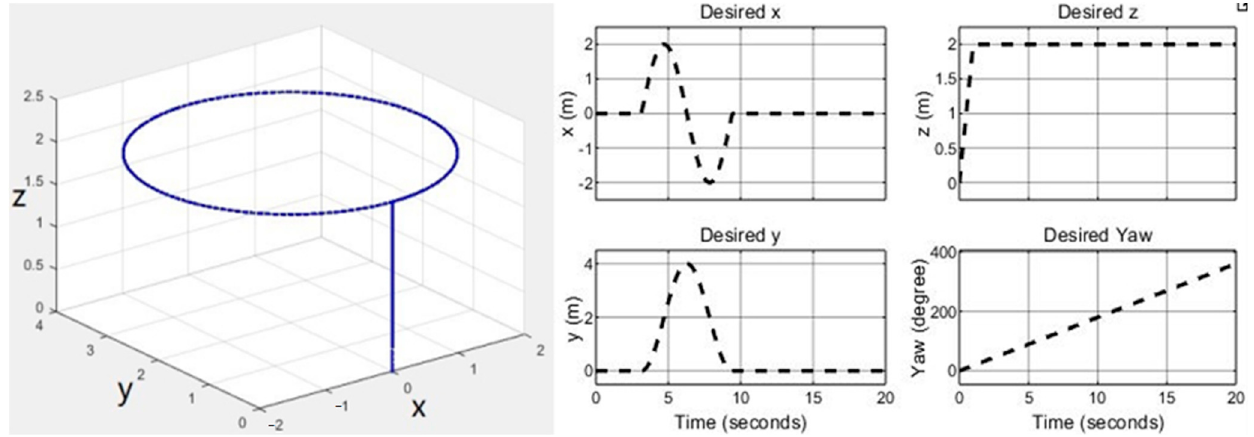
Figure 9. Test trajectory in the 3D coordinate system.